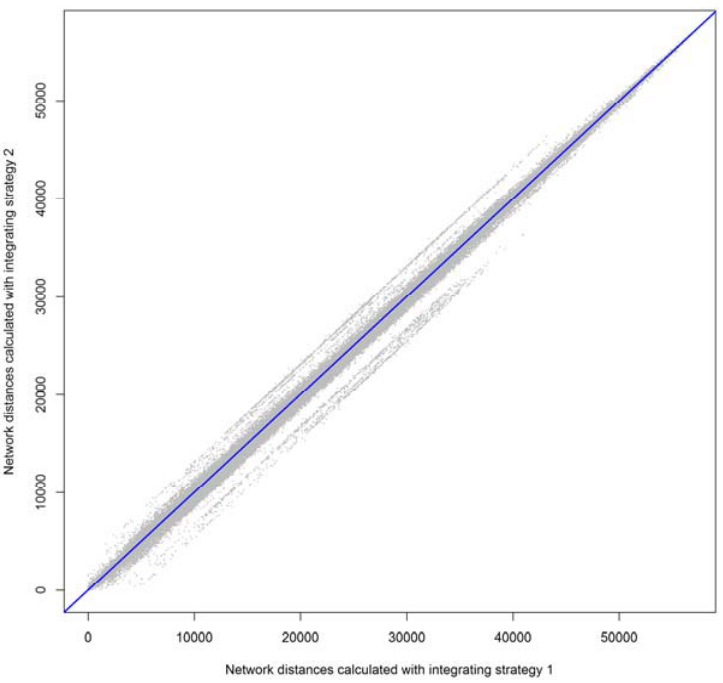
Figure 12. Network distances calculated with two different integrating strategies (London case study).